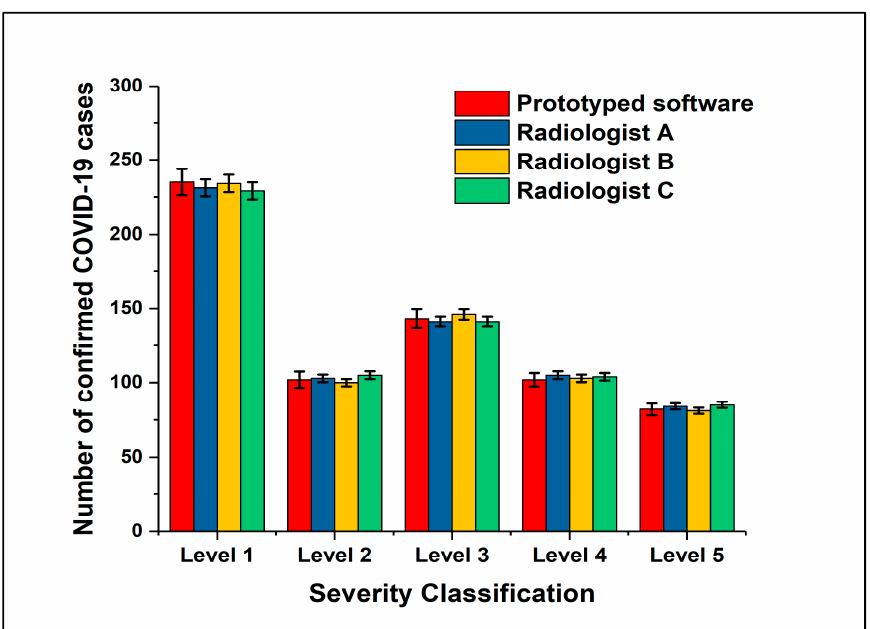
Figure 3. Evaluation data provided by three radiologists compared to the prototype color-thresholding auto-detection method.